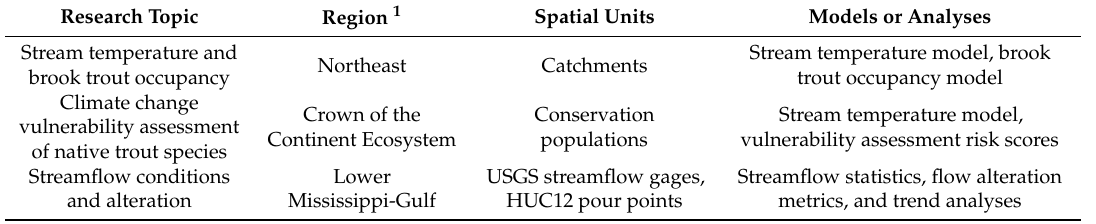
Table 1. Comparison of the three projects including their research topics, regions, spatial units